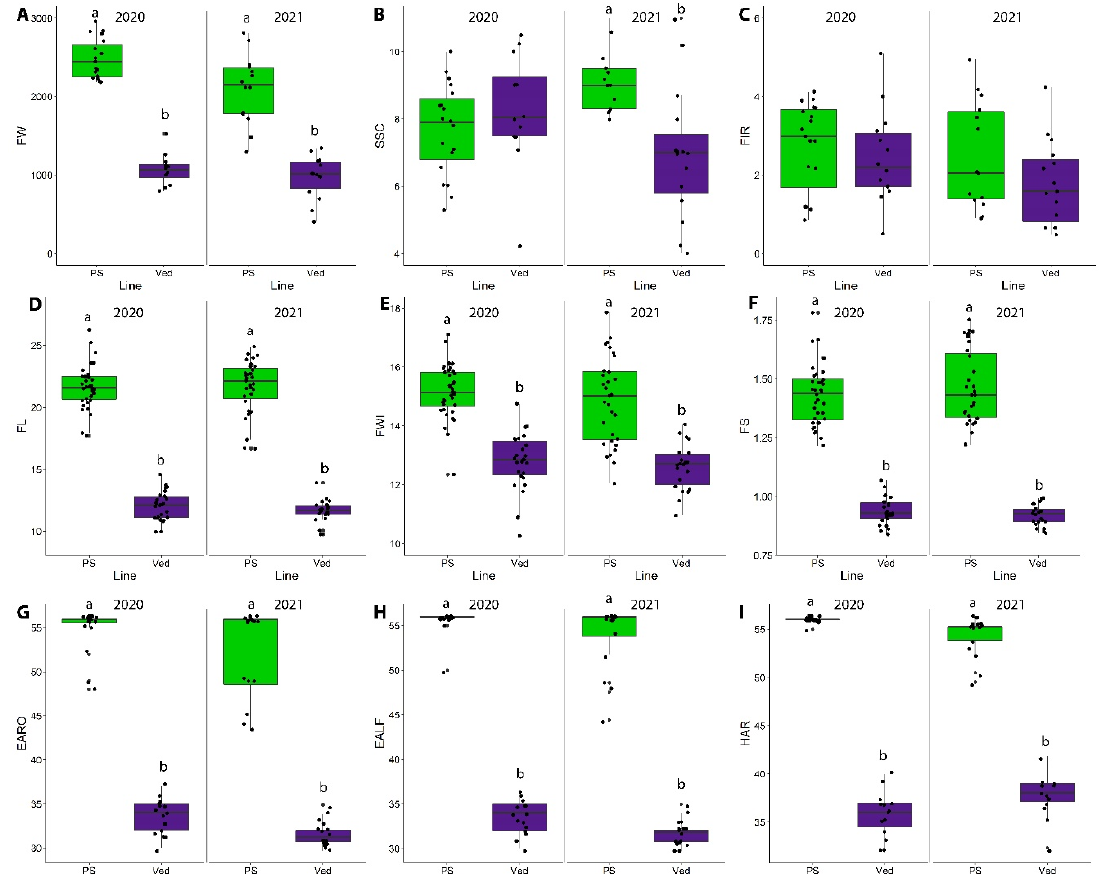
Figure 1. Fruit-quality-, fruit-morphology- and fruit-ripening-related phenotypes of the parental lines PS and Ved in 2020 and 2021. ( A ) Fruit weight (FW) (g). ( B ) Soluble solid content (°Brix) (SSC). ( C ) Flesh firmness (kg cm − 2 ) (FIR). ( D ) Fruit length (cm) (FL). ( E ) Fruit width (cm) (FWI). ( F ) Fruit shape (FS). ( G ) Presence of aroma (days after pollination) (EARO). ( H ) Abscission layer formation (days after pollination) (EALF). ( I ) Harvest date (days after pollination) (HAR). Replicates are represented with dark circles. Different letters (a, b) represent significantly different groups ( p ‐ value < 0.05).